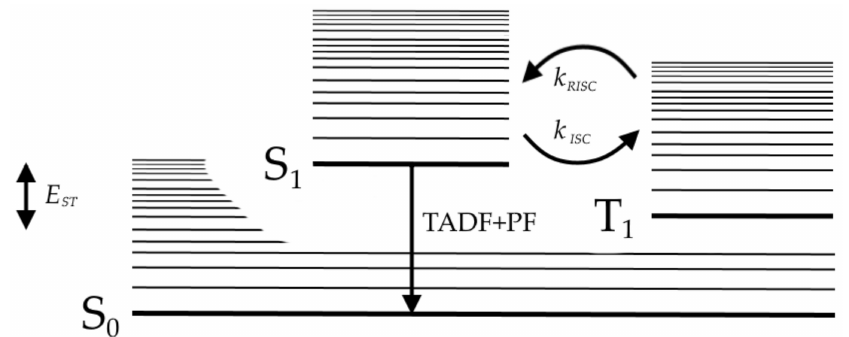
Figure 1. Simplified Jablonski diagram for TADF